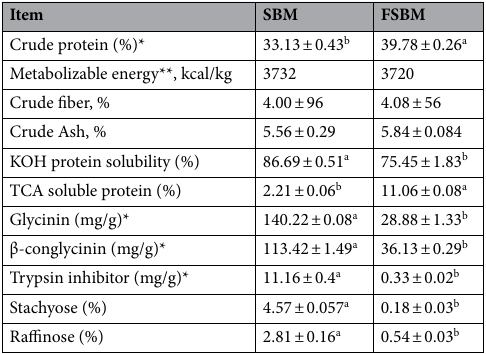
Table 1. Compositions of soybean meal (SBM) and fermented soybean meal (FSBM). *On a dry matter basis; a,b , Means within rows with different letters differed significantly (P < 0.05). The comparison was conducted in a horizontal manner. **Metabolizable energy of SBM, FSBM is